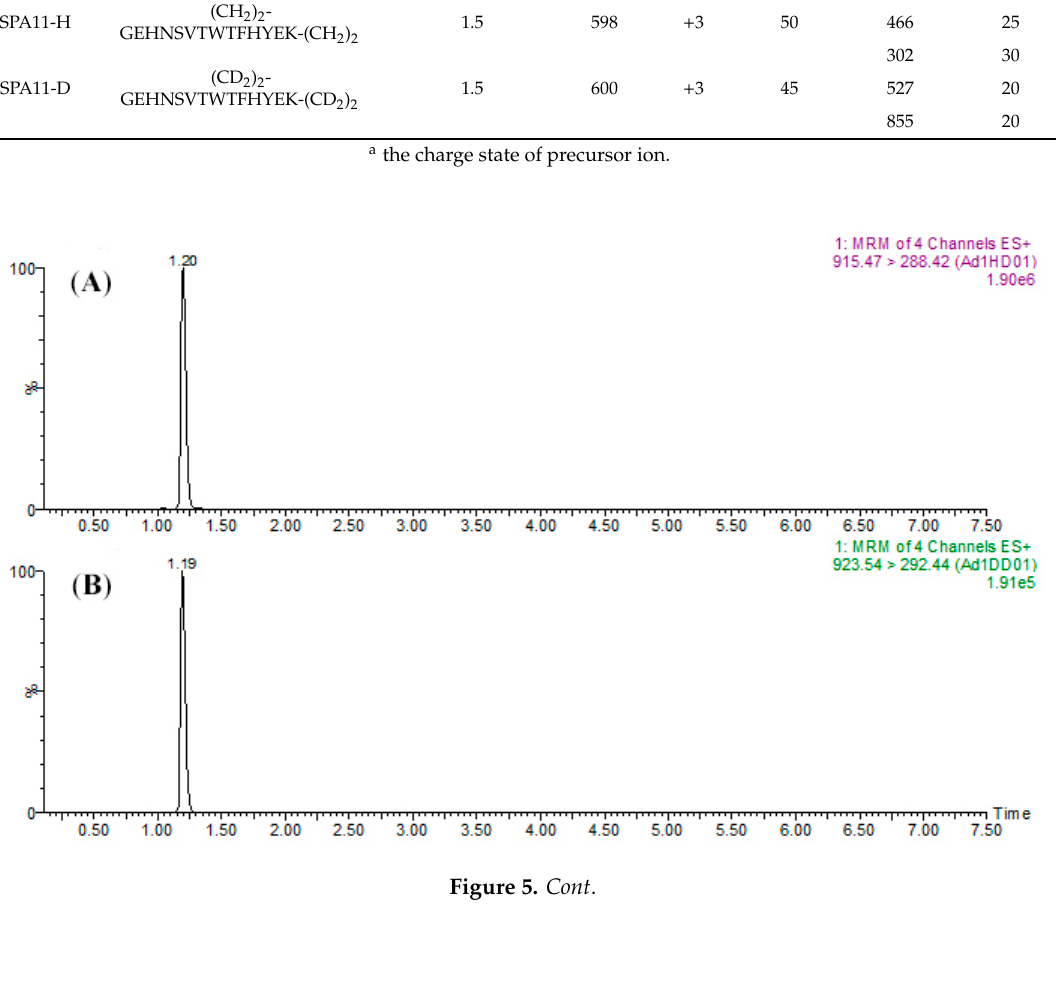
Figure 5. MRM chromatograms of ( A ) SPA1-H (1 μ g mL − 1 ) and ( B ) SPA1-D (500 ng mL − 1 ) for the mixture of peptide standards and ( C ) SPA1-H (479.3 ng mL − 1 ) and ( D ) SPA1-D (500 ng mL − 1 ) for kiwifruit raw extract samples. 2.5. Method Validation Prior to the quantification of the allergen commodities, this method was assessed for its linearity, sensitivity, recovery, and repeatability. The calibration curves were generated by plotting the ratio of the area of the external calibrants and internal standards to the concentration of the spiked external calibrants. As shown in Table 2, good linearity (R 2 ≥ 0.99) was observed in the range of 0.008–4000 ng mL − 1 for SPA1-H, in the range of 8–4000 ng mL − 1 for SPA5-H, and in the range of 20–4000 ng mL − 1 for SPA11-H. Regarding the sensitivity, the limits of detection (LODs) ranged between 8 pg mL − 1 and 8 ng mL − 1 , and the limits of quantification (LOQs) were between 8 pg mL − 1 and 20 ng mL − 1 , depending on the signature peptides.